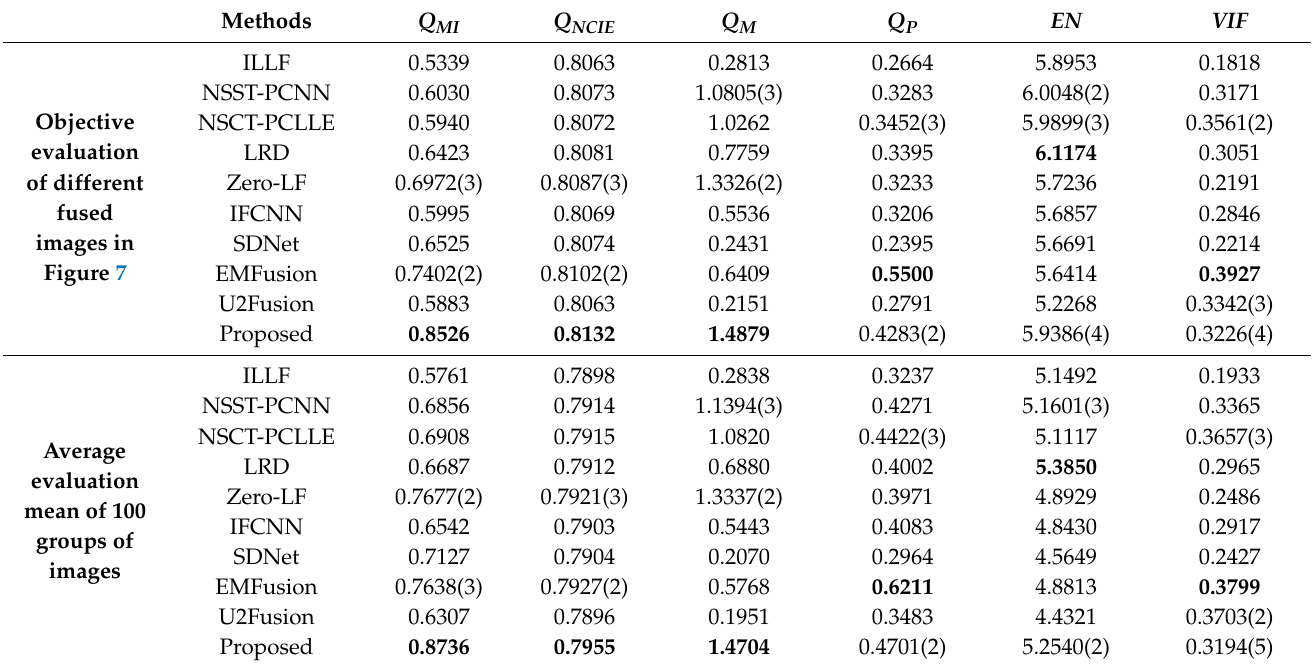
Table 4. Comparison of performance of proposed fusion method with those of nine methods on MRI-SPECT images; the best results are shown in